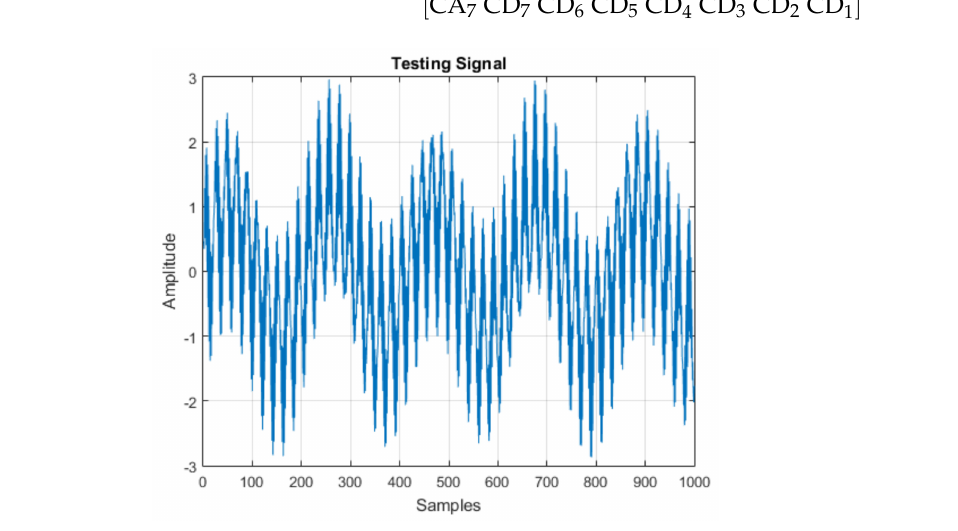
Figure 4. Test signal for MRA.